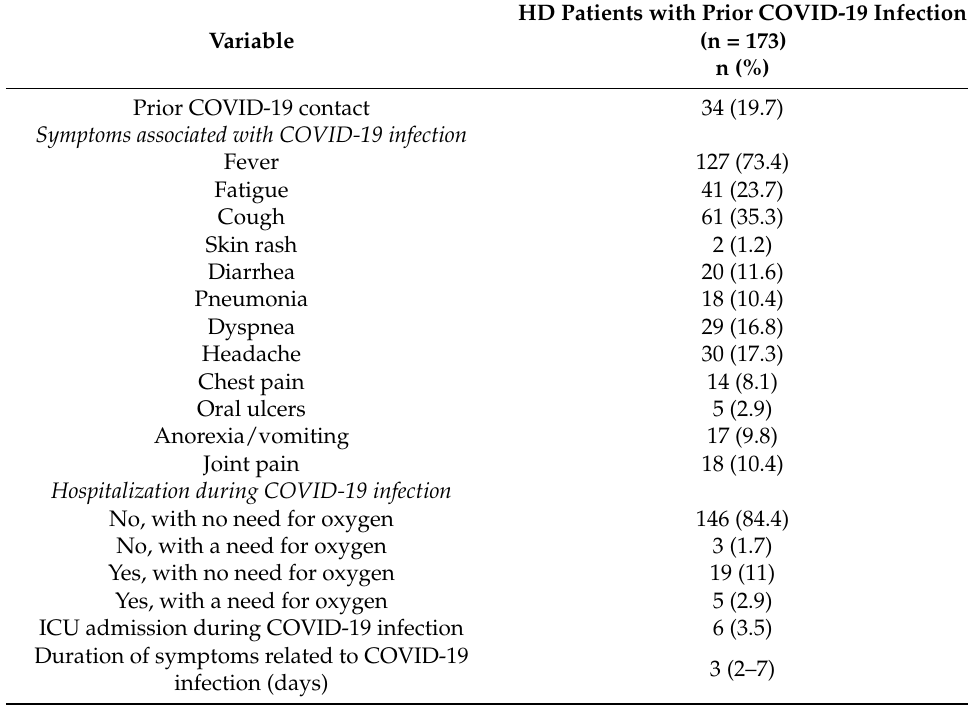
Table 2. Clinical characteristics of COVID-19 infection among the studied HD patients (n =